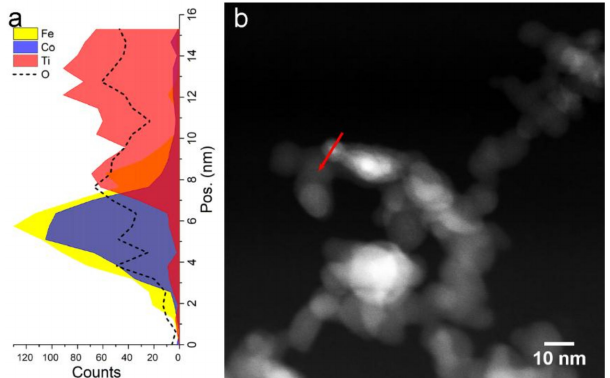
Figure 12. ( a ) EDX profile acquired along the path indicated with a red arrow in the corresponding STEM image ( b ) of the Fe 50 Co 50 /TiO x sample showing a Fe-Co NP in contact with TiO x NPs.